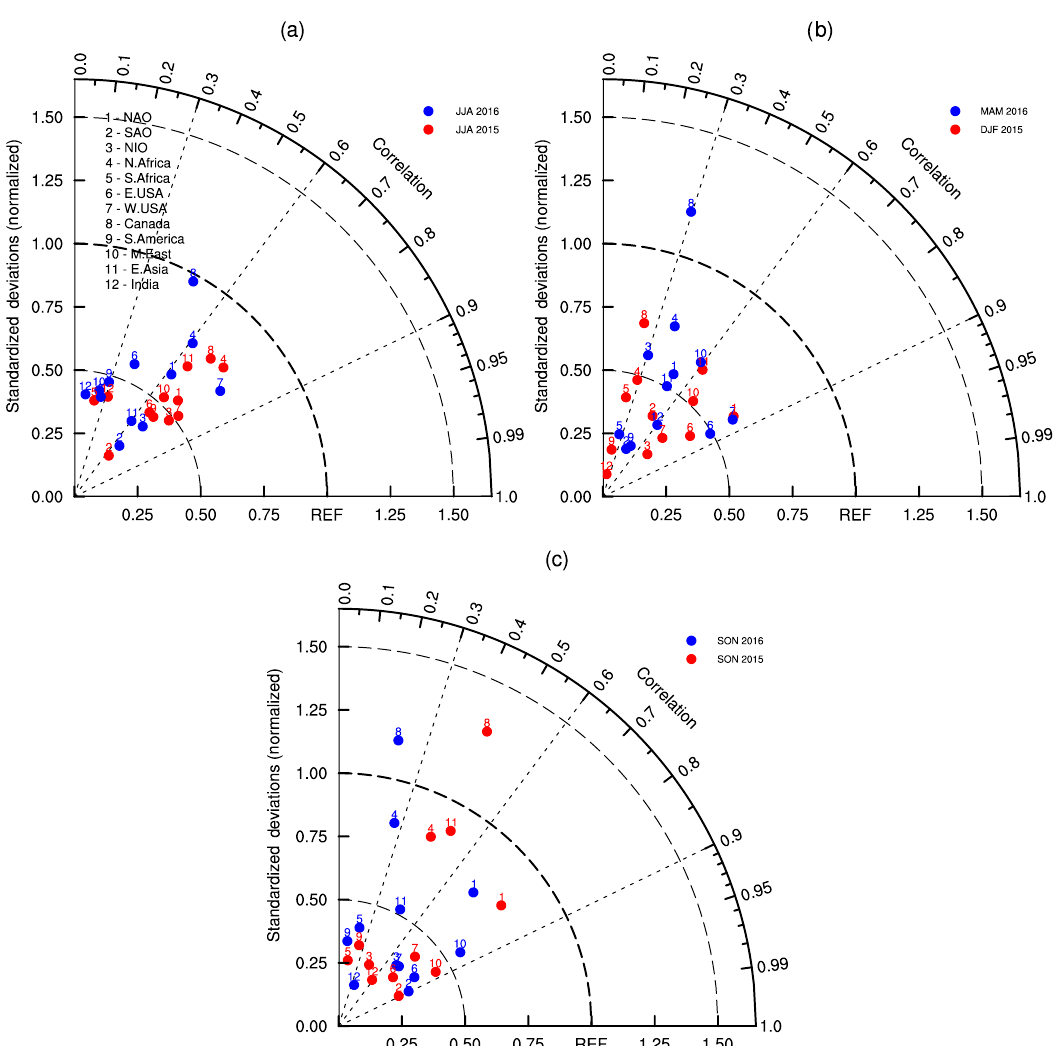
Figure 5. Taylor diagrams for (a) JJA, (b) MAM and DJF, and (c) SON between NGACv2 and MODIS over 12 regions described in Table 1. On the Taylor diagrams, angular axes show spatial correlations between modeled and observed fields; radial axes show spatial standard deviation normalized against that of the observations. Each dot represents a region in Table 1 identified by its number on top. NAO: North Atlantic Ocean; SAO: South Atlantic Ocean; NIO: North Indian Ocean in the